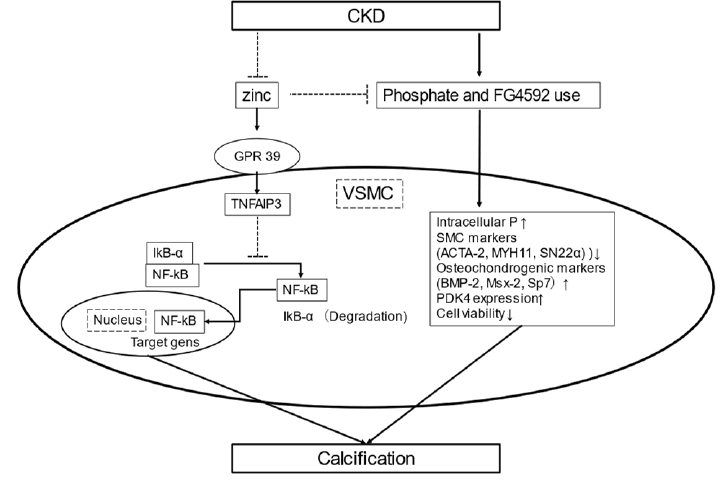
Figure 1. Schematic illustration of zinc and calcification. CKD induces hypozincemia and